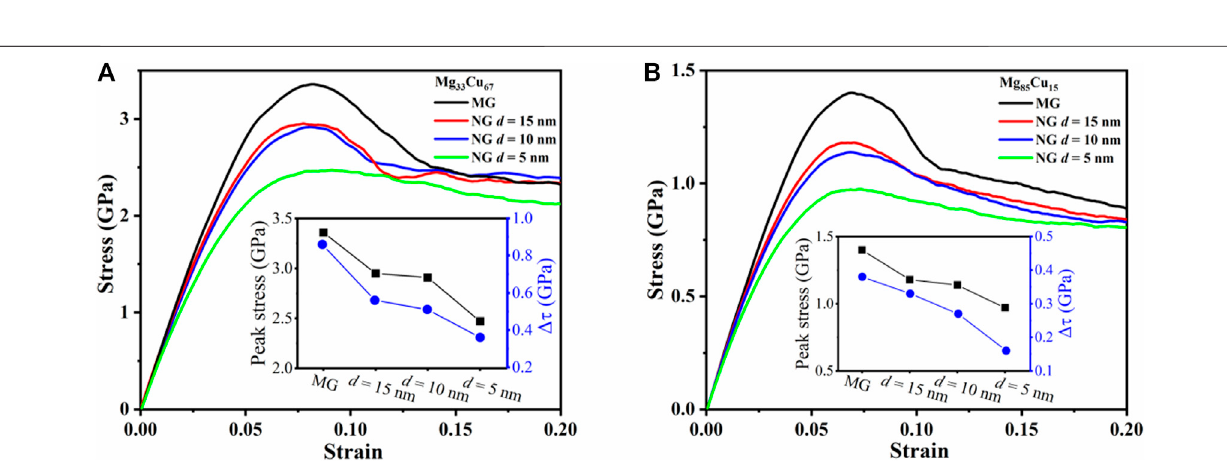
Frontiers in Materials |